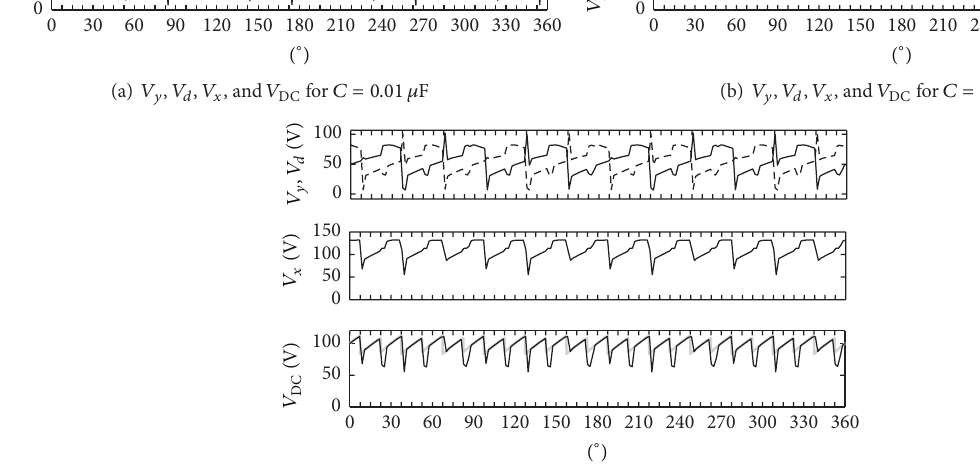
(b) 𝑉 𝑦 , 𝑉 𝑑 , 𝑉 𝑥 , and 𝑉 DC for 𝐶 = 0.1𝜇 F